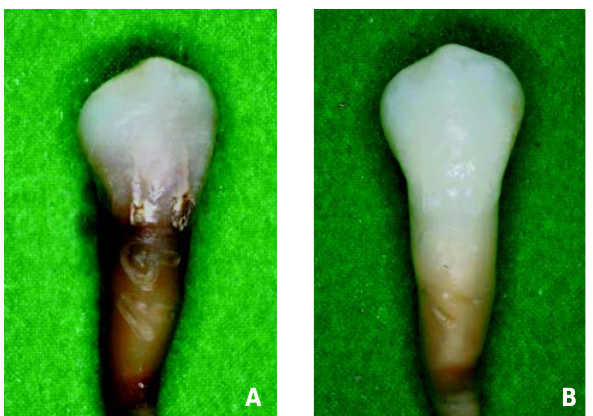
FIGURE 4- Specimen representative of group G3 after discoloration (A) and after 21 days of bleaching (B) with tetrahydrate sodium